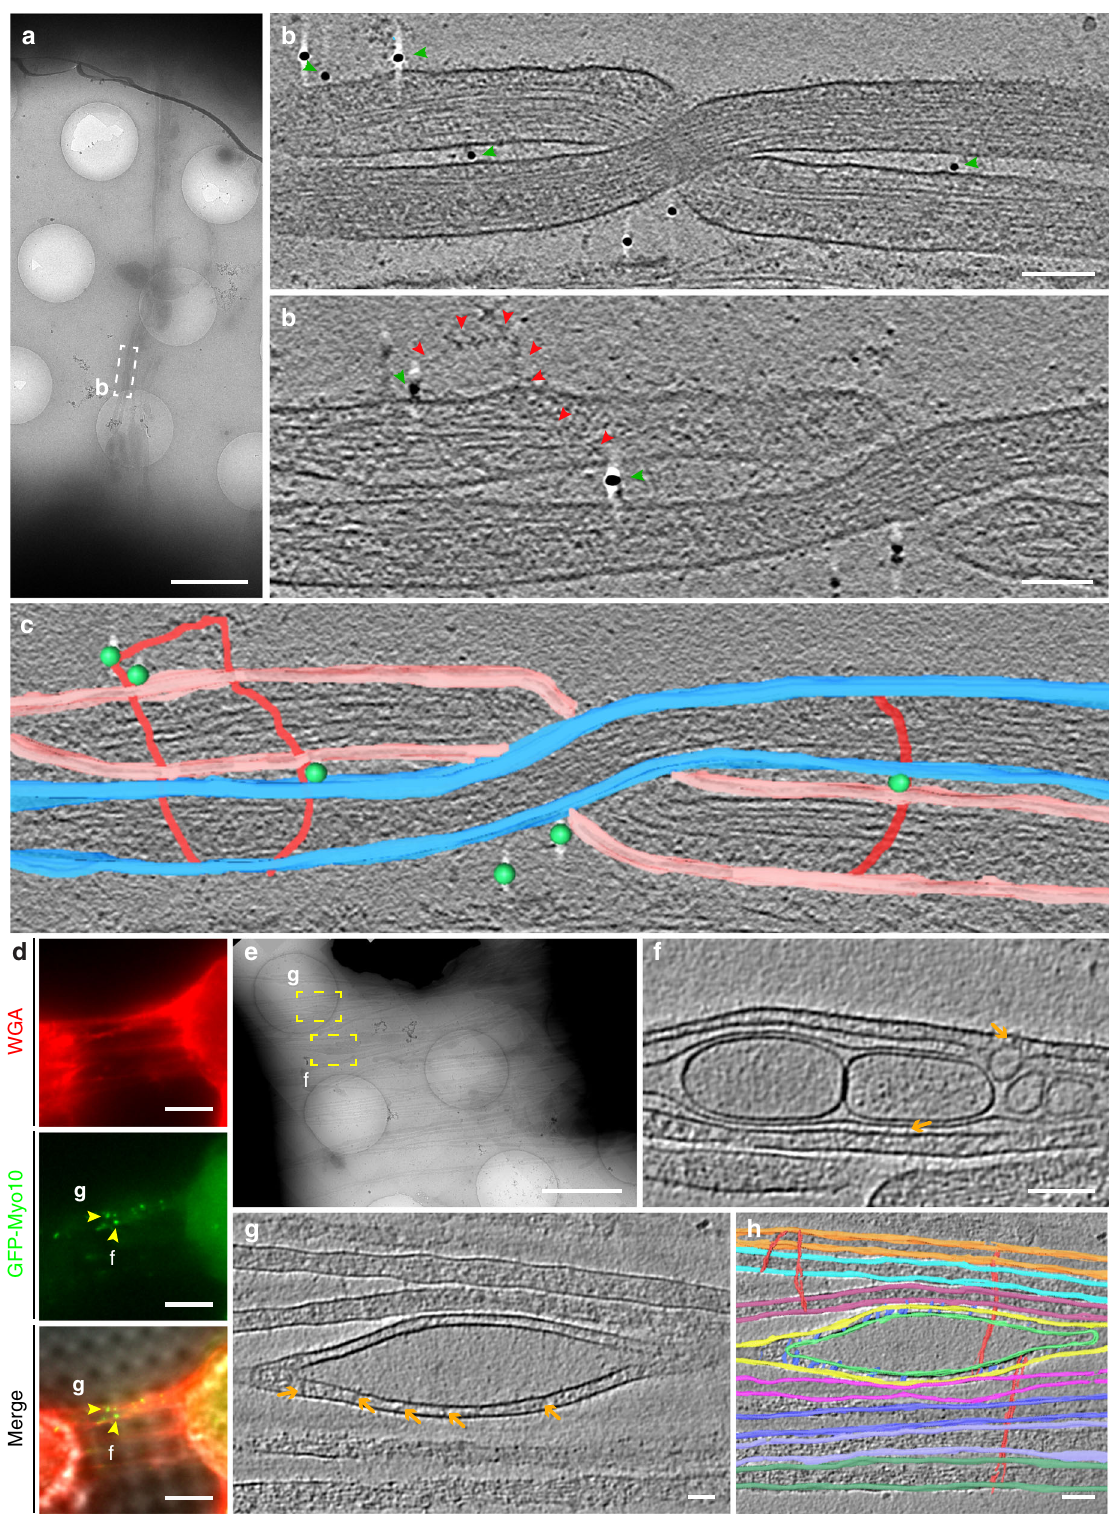
TNTs connecting CAD cells were fi rst identi fi ed by FM (Fig. 7a) and subsequently imaged by FIB-SEM. Under the imaging conditions used, the resolution of our tomograms was suf fi cient to discern plasma membrane boundaries of cells and TNTs. Manually segmented tomogram renderings (right panel, Fig. 7a) and volume renderings created with the